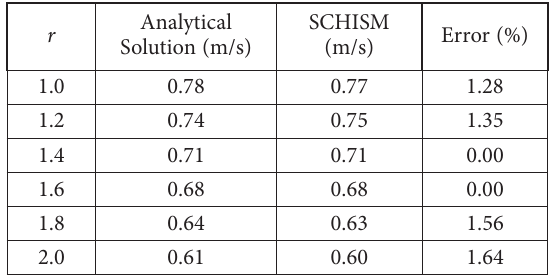
Table 3. Error of velocity comparison at centreline ( s = 0) between analytical solution and SCHISM results